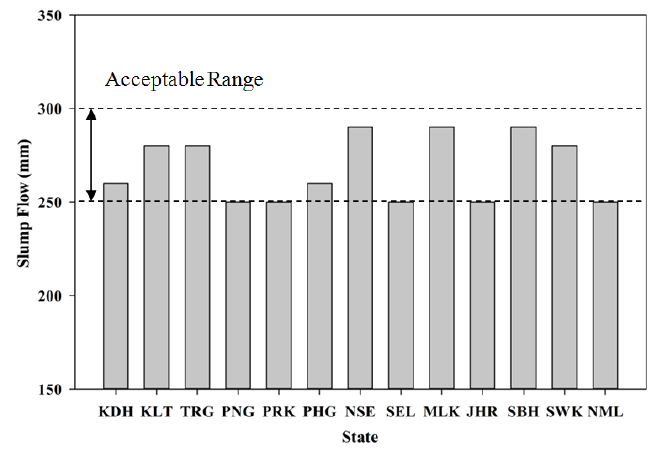
Figure 10. Slump flow test results.